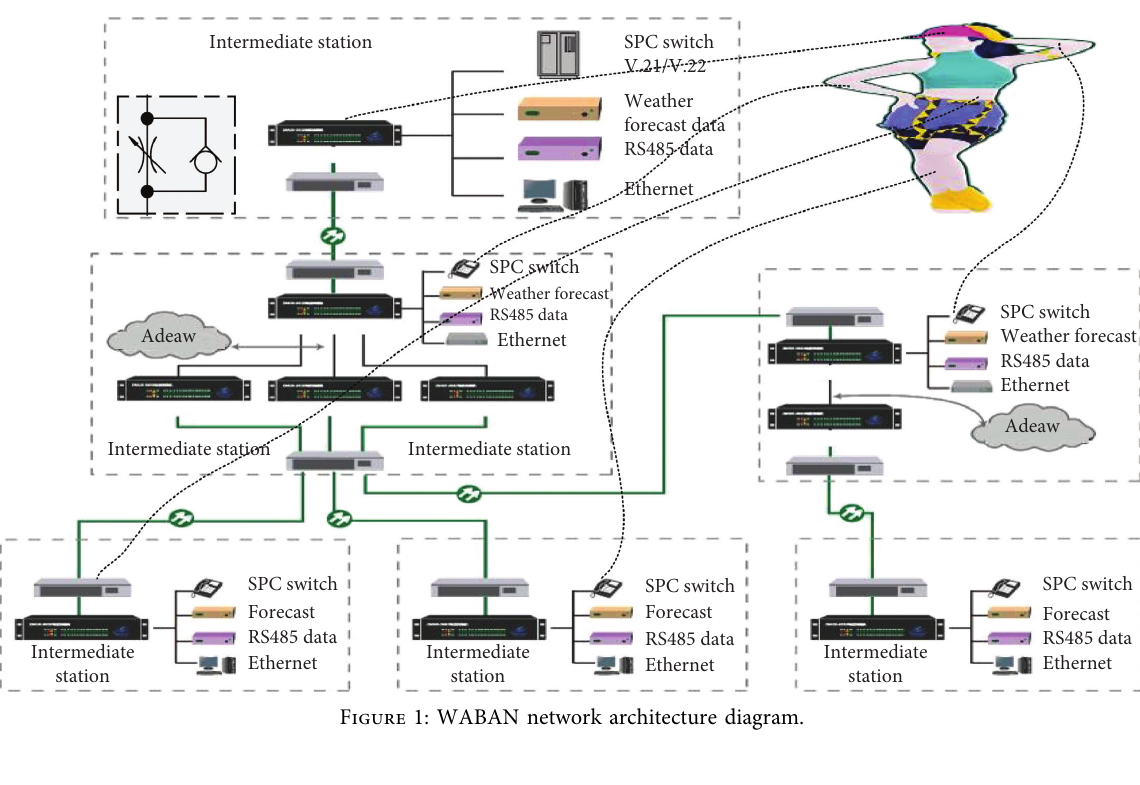
Figure 1: WABAN network architecture